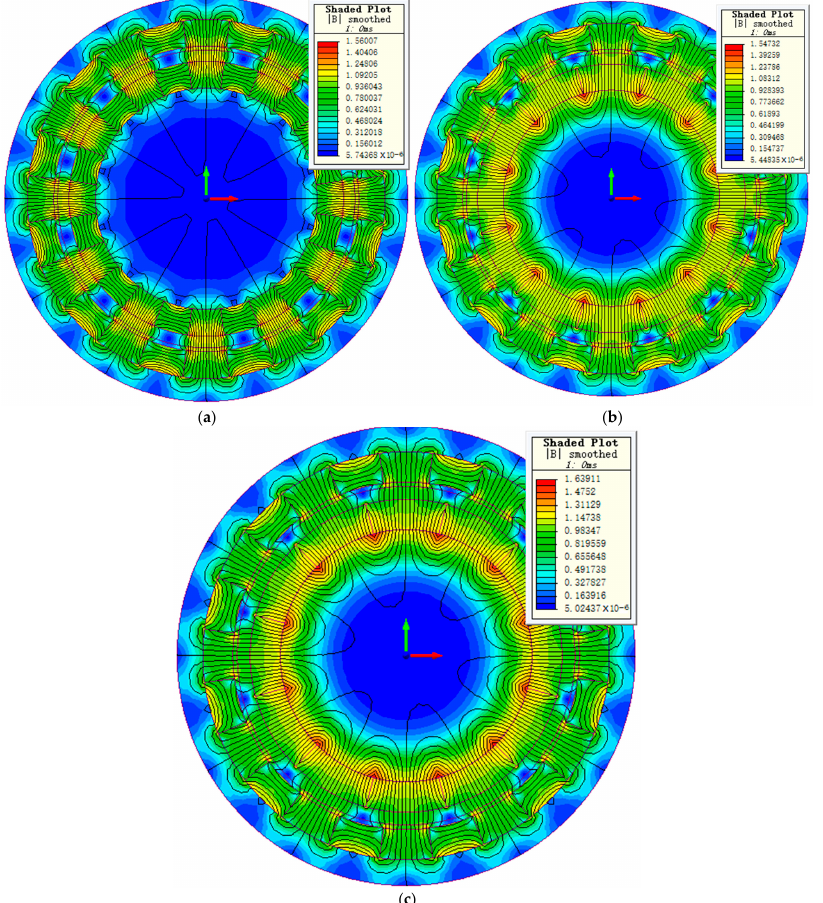
Figure 5. Finite element analysis (FEA) models and flux distributions of HPMCs. ( a ) Type-1, ( b ) Type-2, and ( c ) Type-3.